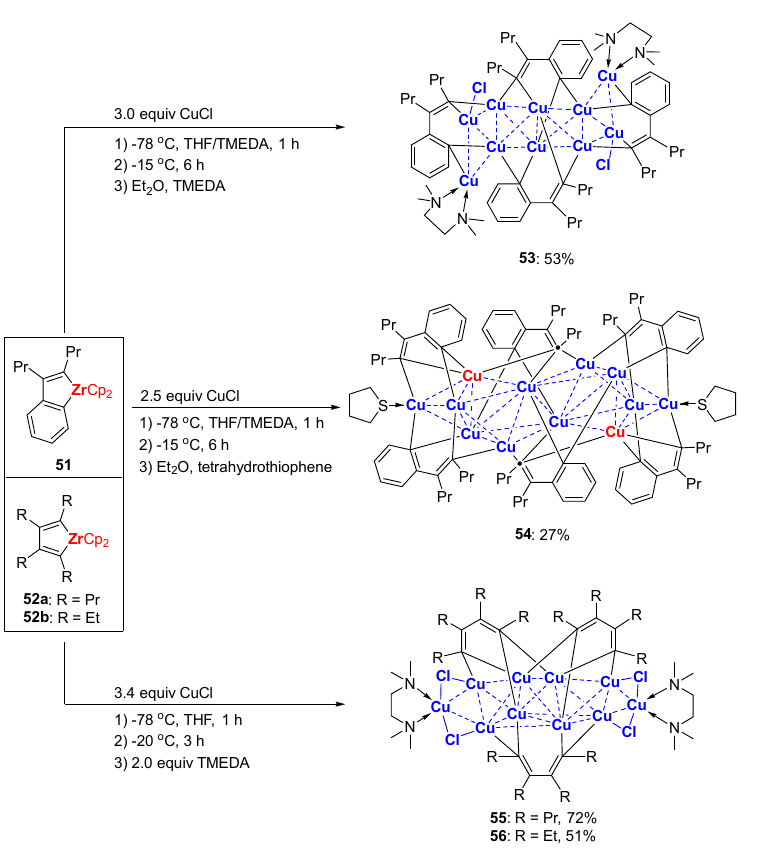
Scheme 14. Styrenyl and budadienyl organocopper aggregates [57].